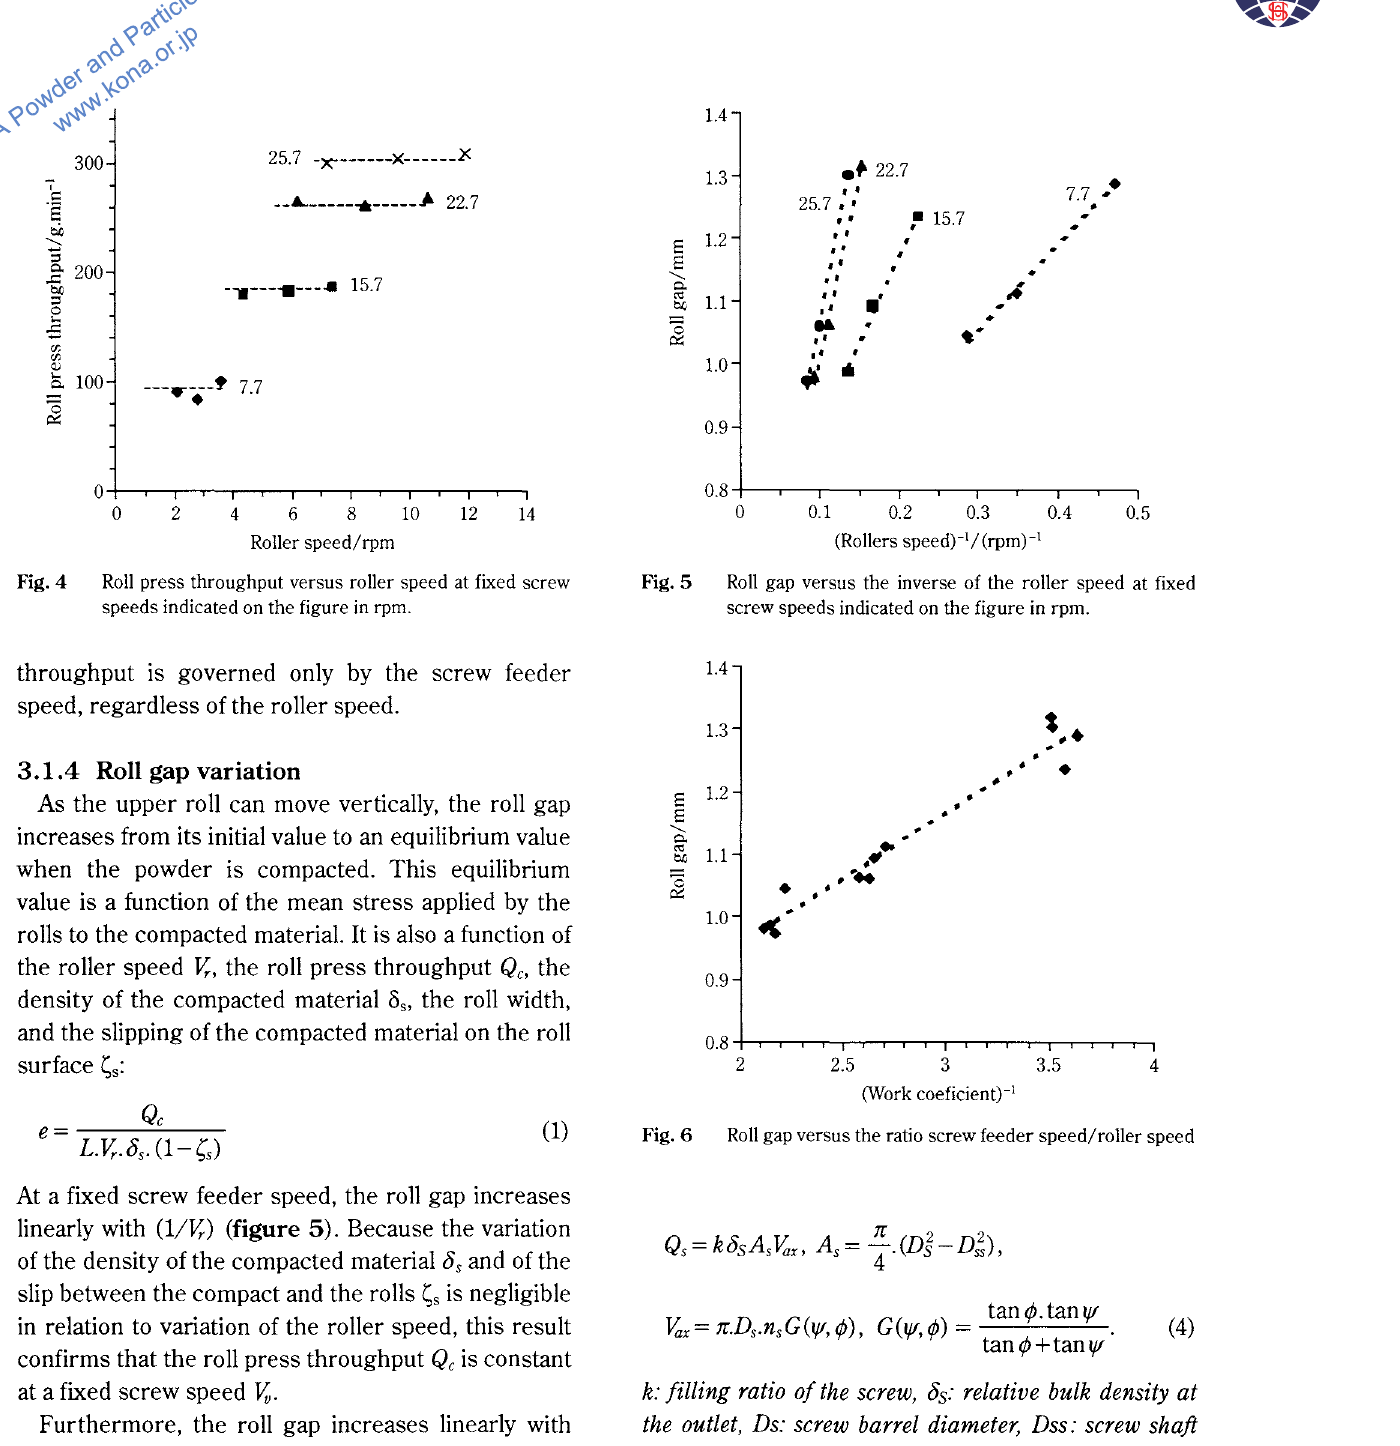
k: filling ratio of the screw, 8 5: relative bulk density